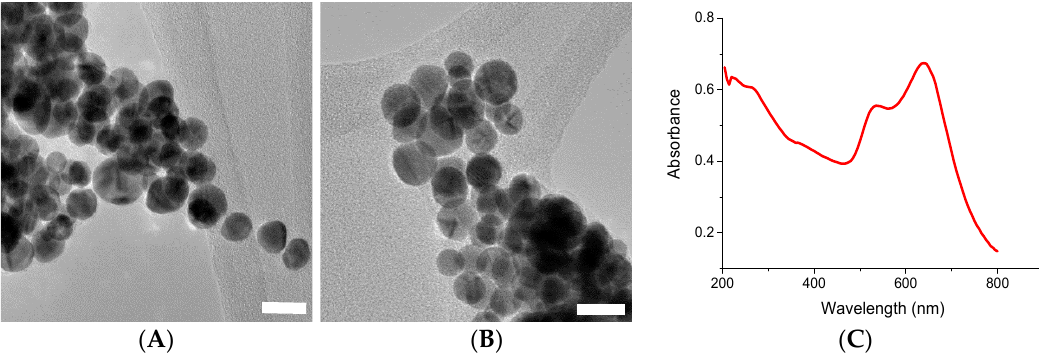
Figure 4. ( A ) and ( B ) are TEM images of PAH-stabilised Au nanoparticles. The scale bars correspond to 20 nm. ( C ) shows the UV-Vis spectrum for the PAH-stabilised gold nanoparticles.